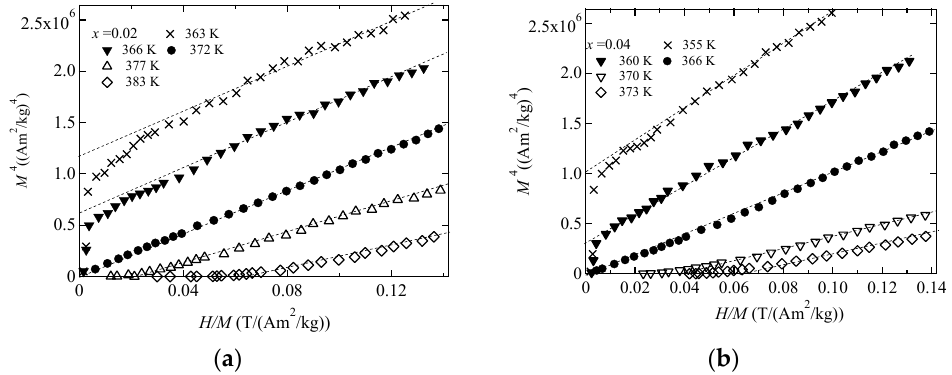
Figure 3. The H / M dependences of M 3.7 for ( a ) x = 0.02 and ( b ) x = 0.04. The dotted straight lines are included as a visual guide.